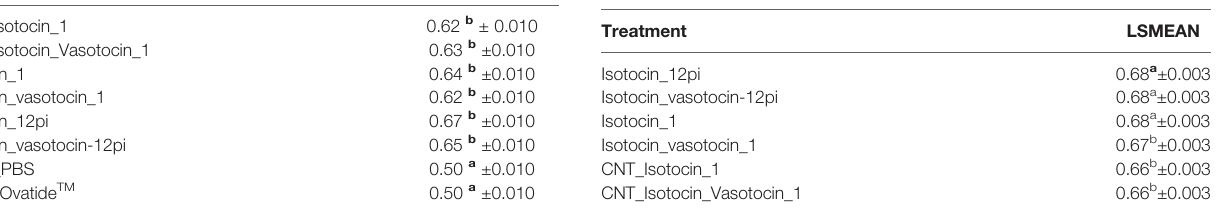
TABLE 6 | Least squares means of fertilization rate for various